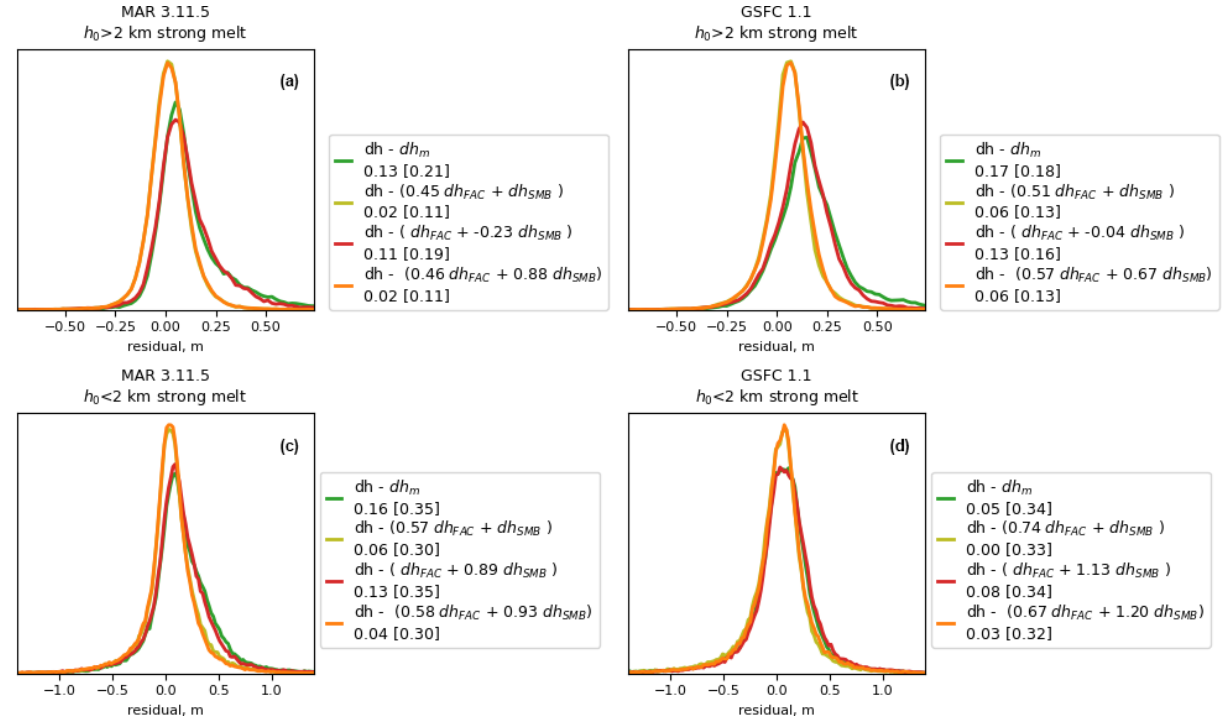
Figure 8. Unscaled-model residuals and regression residuals for individual model components of the MARv3.11.5 (a, c) and GSFCv1.1 (b, d) models, for the high-elevation (a, b) and low-elevation (c, d) subsamples of the high-melt ( z melt > 0 . 2 | dh m | ) data. Model components listed in the legends are the firn-air-column change ( dh FAC ) and the surface-mass-balance height change ( dh SMB ). The mean and [standard deviation] of the residuals are given in each legend. Note that in each of these plots, the histogram for the separate rescaling of dh FAC and dh SMB is nearly identical to that for rescaling of dh FAC alone, so the histograms for dh FAC are not separately